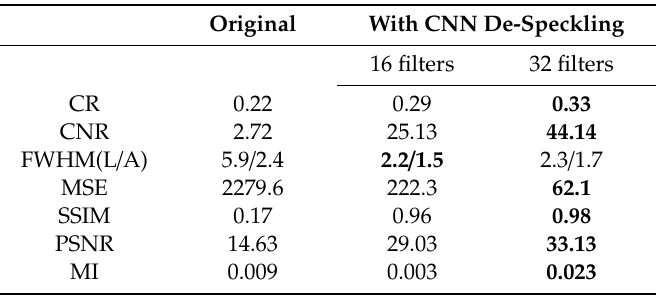
Table 4. Quantitative analysis of di ff erent minimum number of convolutional filters.